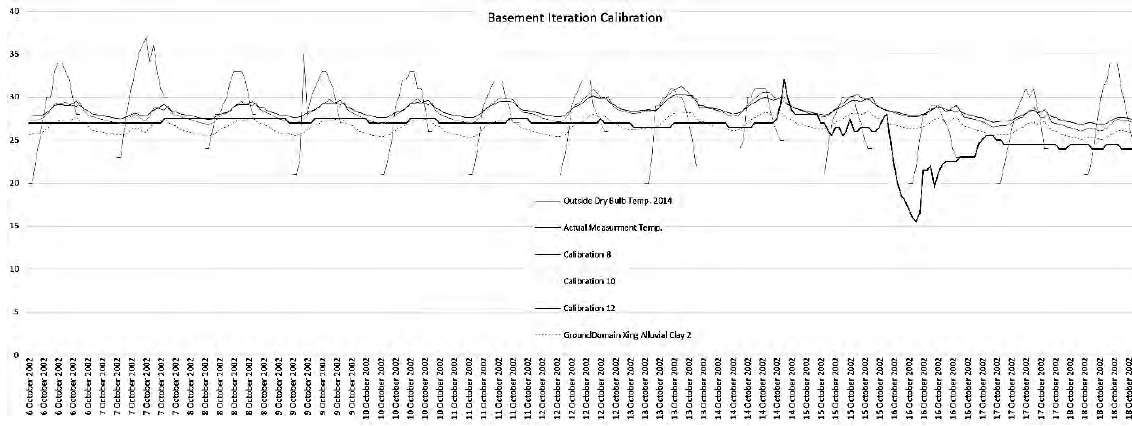
Figure 11. The most visually typical sequence that is near-to-actual trials during the basement calibration process, using the ground temperature from the iterative approach, compared with the Site: GroundDomain: Basement, Xing approach